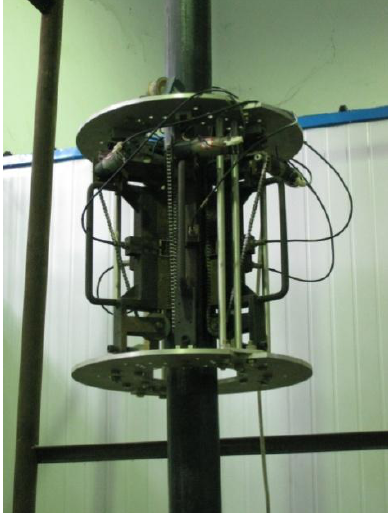
Figure 14. Prototype of the transducer detecting the sample cable in the